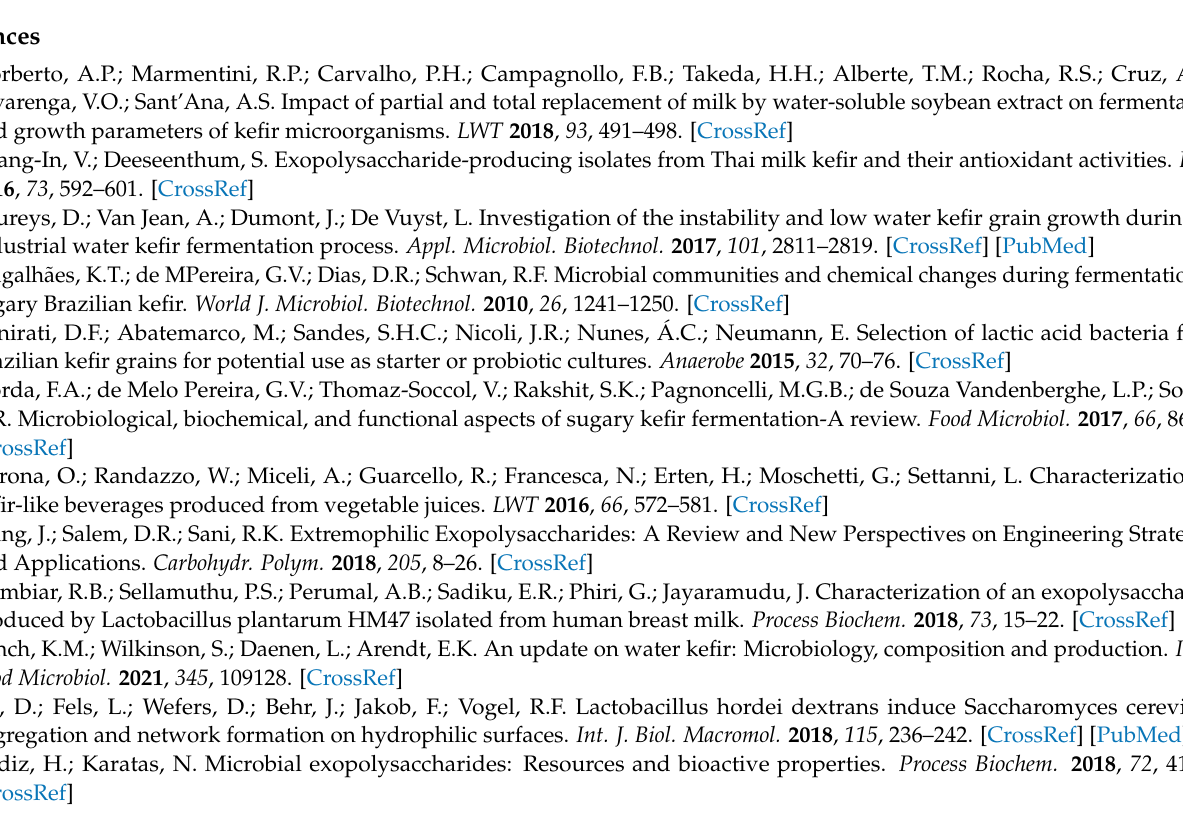
Figure S3: pH values of EPSwk in different concentrations; Figure S4: Electrical conductivity of EPSwk in different concentrations; Figure S5: (a) Film of EPSwk without the addition of plasticizer. (b) Film of EPSwk with 10% of glycerol; Figure S6: Schematic diagram of the mucoadhesiveness test by the texture analyzer. (A) The probe with the sample was moved downward; (B) The sample was attached to porcine buccal mucosa; (C). The probe moves up at a specified speed; Figure S7: (a) Hemocompatibility analysis of EPSwk. (b) Negative and positive